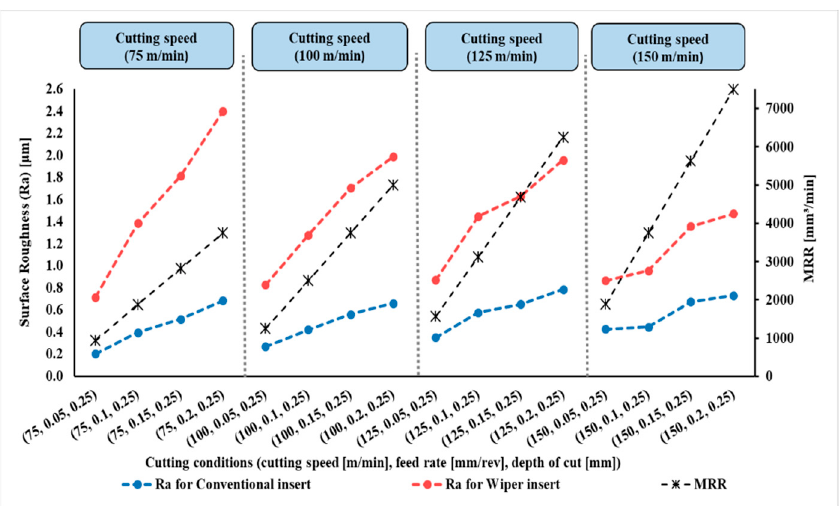
Figure 7. Surface roughness (Ra) and material removal rate (MRR) for AISI 4340 workpieces ma- chined by wiper and conventional inserts at depth of cut ( a p ) of 0.25 mm and variable cutting speeds and feed rates (reproduced results originally reported in [6]).